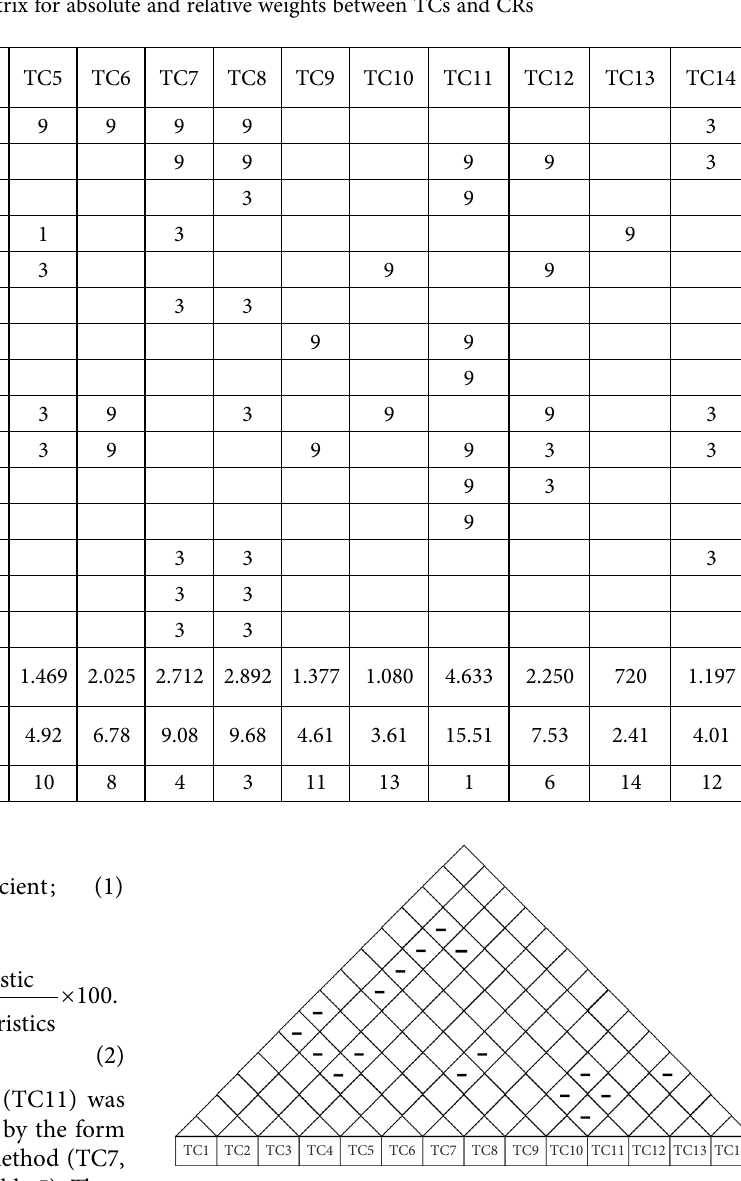
Figure 5. Contradiction check between